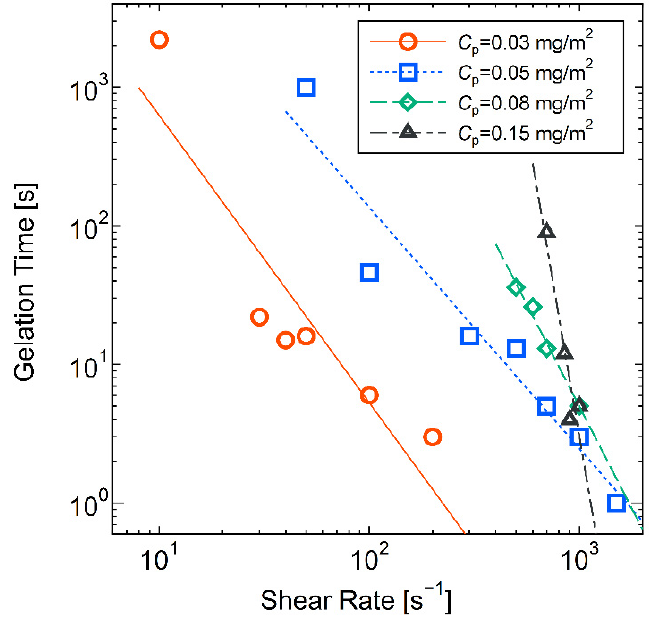
Figure 5. Relationships between applied shear rate and the gelation time at which temporal increase in viscosity value was maximum at different C p with ( ○ ) 0.03 mg/m 2 , ( □ ) 0.05 mg/m 2 , ( ◇ ) 0.08 mg/m 2 , and ( △ ) 0.15 mg/m 2 , respectively. Each plot was obtained from the experimental data in Figure 3, and the dotted lines were approximated using the least-squares method. The PEO molecular weight was 1000 kg/mol. The samples with C p values smaller than 0.03 mg/m 2 did not change to a gel-like state under the steady shear. Table 2. The parameters of the power-law approximation are calculated using Equation (3), where ˙ 𝑡 to the shear rate. The values of k and a are the constants (cid:3008) corresponds to the gelation time and 𝛾 of the power–law relationship, and the values of a correspond to the slope of the graph. The values of R 2 are the coe ffi cient of determination for the least-squares method.